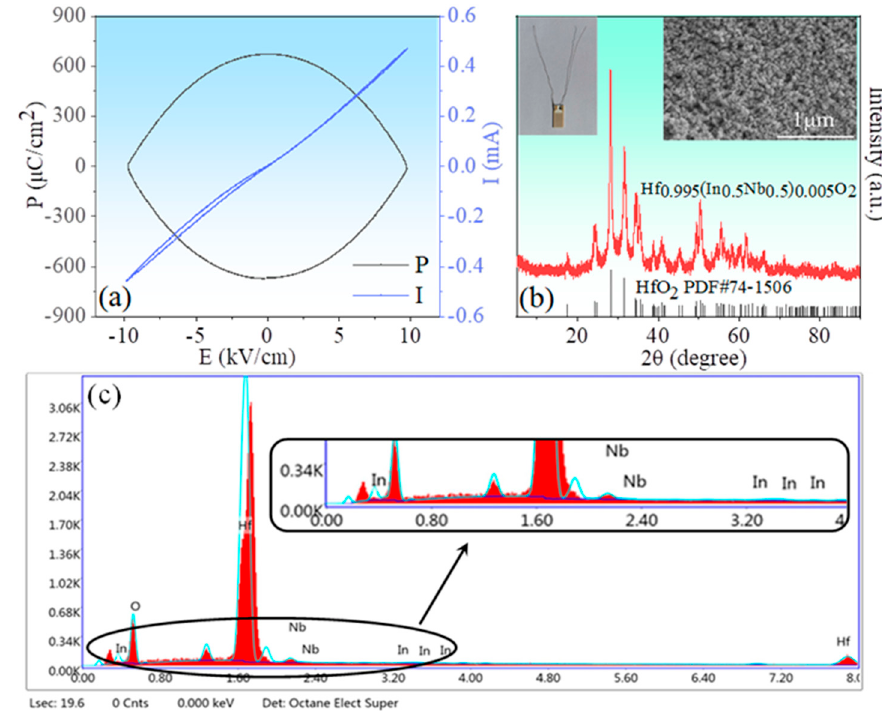
Figure 6. ( a ) P-E loop and I-V curves of HINO-0.005; ( b ) XRD patterns (main panel), SEM image (right inset), and picture of the sensor (left inset) of HINO-0.005; ( c ) EDS spectrum for HINO-0.005. Table 1. Local elemental compositions of the HINO-0.005 deduced from EDS.